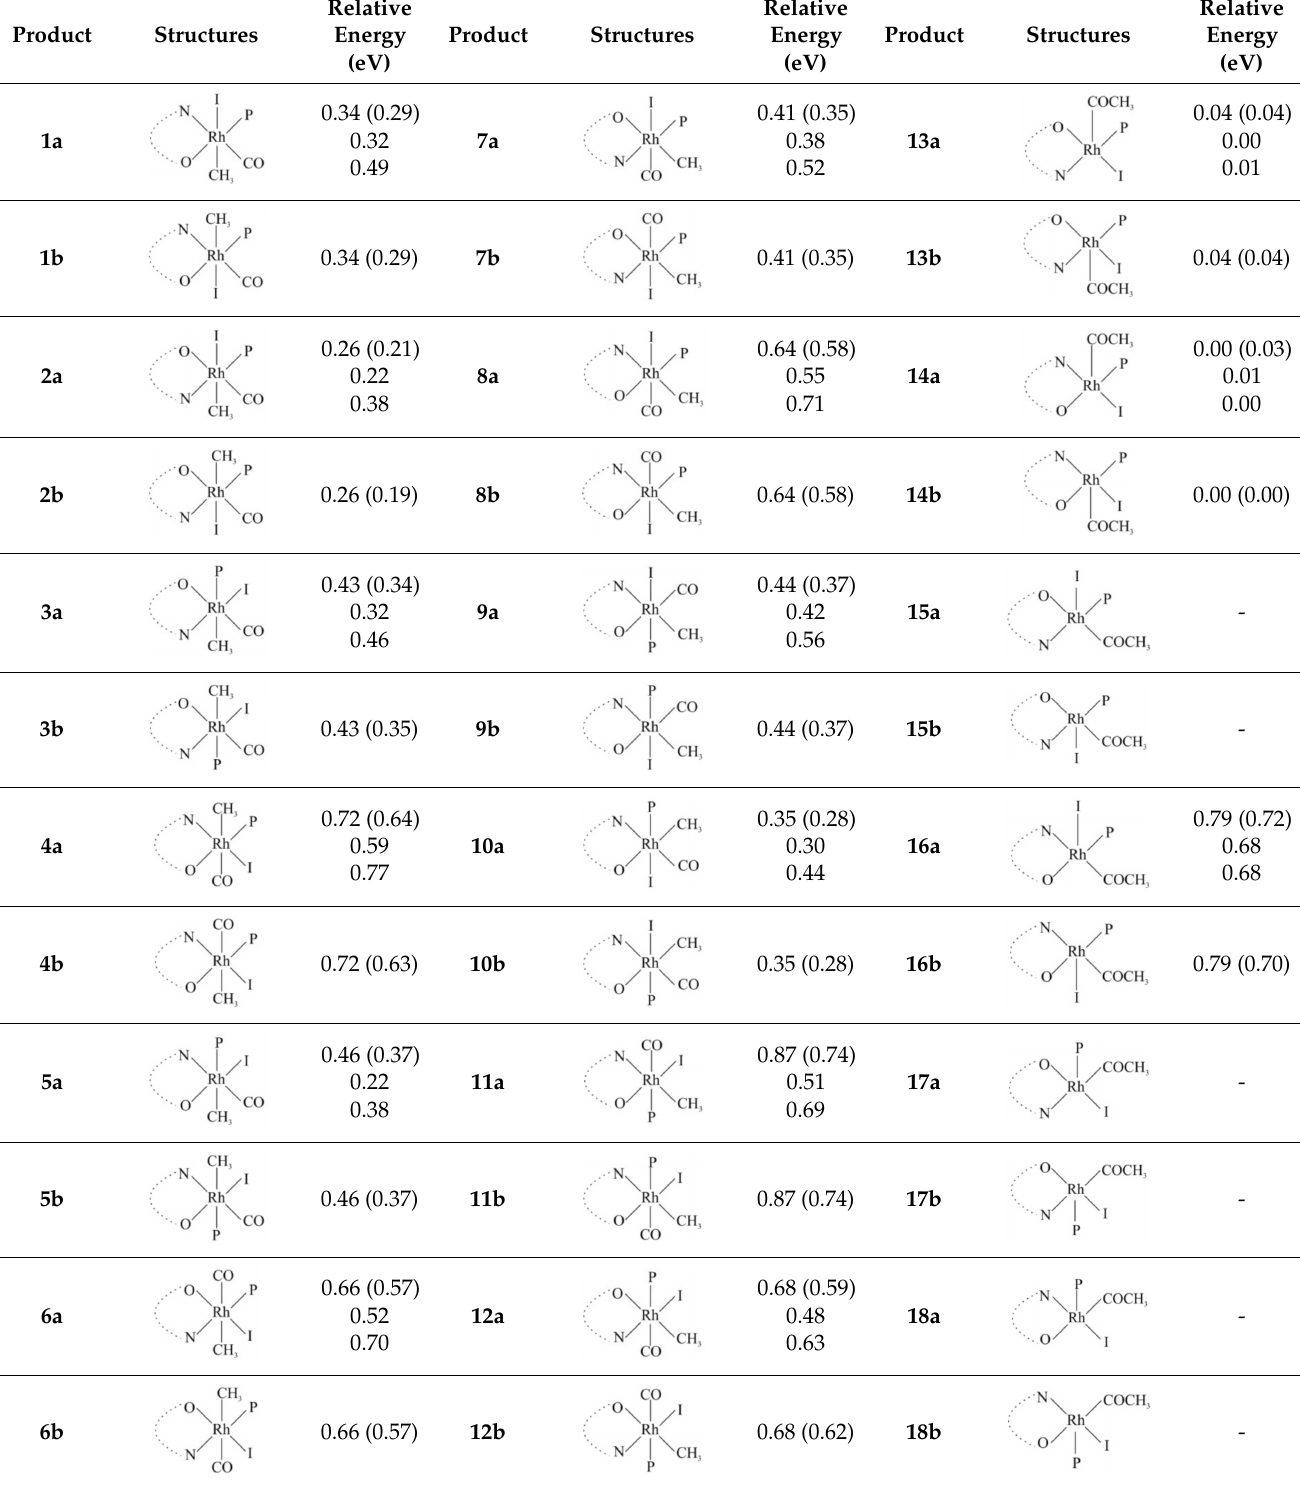
Table 1. Calculated energies (using different DFT methods) and structures of the possible alkyl (1–12) and acyl (13–18) products of the oxidative addition reaction [Rh(CH 3 COCHCNHCH 3 )(CO)(PPh 3 )] 3A + CH 3 I. In each cell the top entry gives PW91/TZP (PW91/TZP ZPE corrected in brackets),